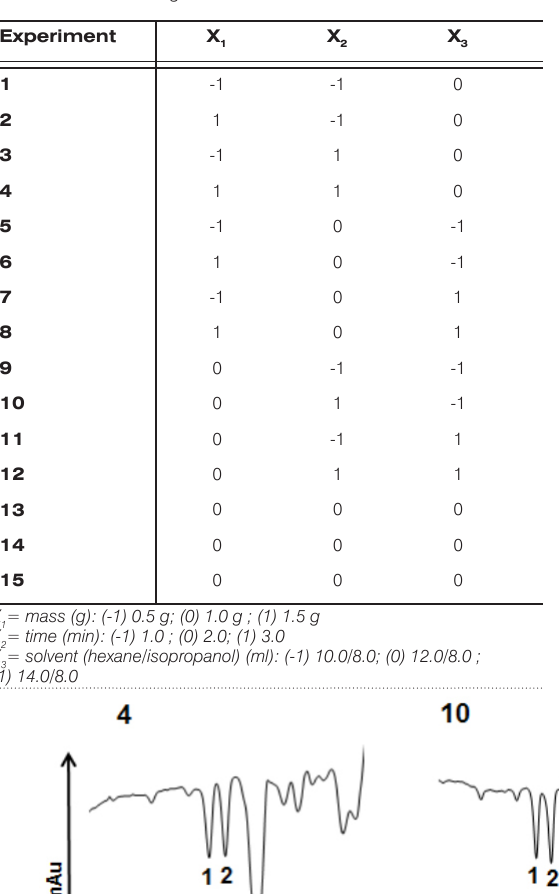
Table 1. 3 3 Box-Behnken experimental design coded matrix containing levels and factors.